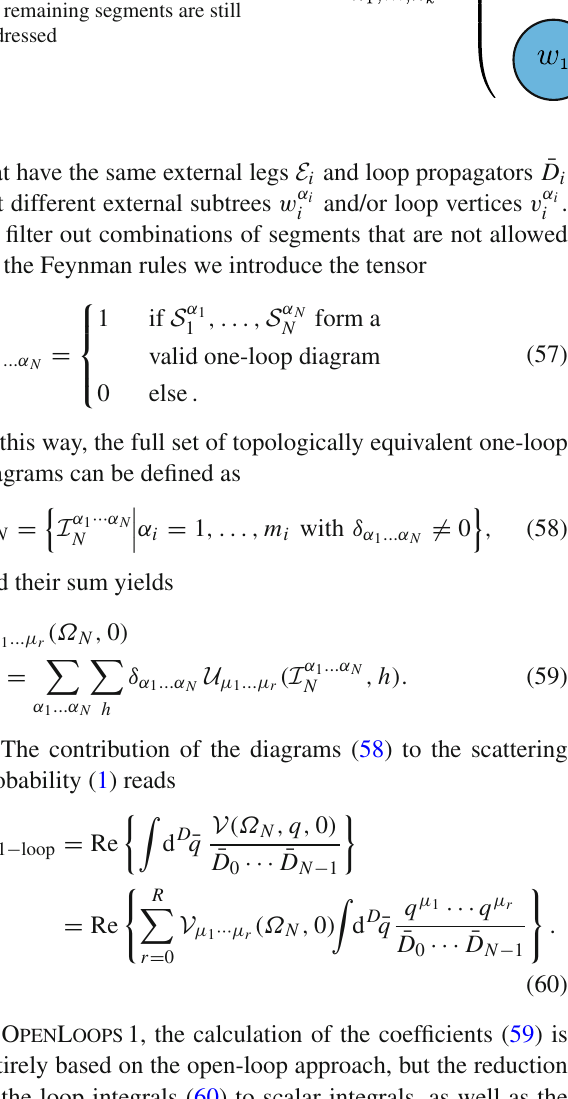
Fig. 3 Schematic representation of the on-the-fly helicity sums in (62). Taking the interference with the Born amplitude makes it possible to sum over the helicities h 1 ,..., h k of the first k dressed segments of an open loop, while the remaining segments are still undressed